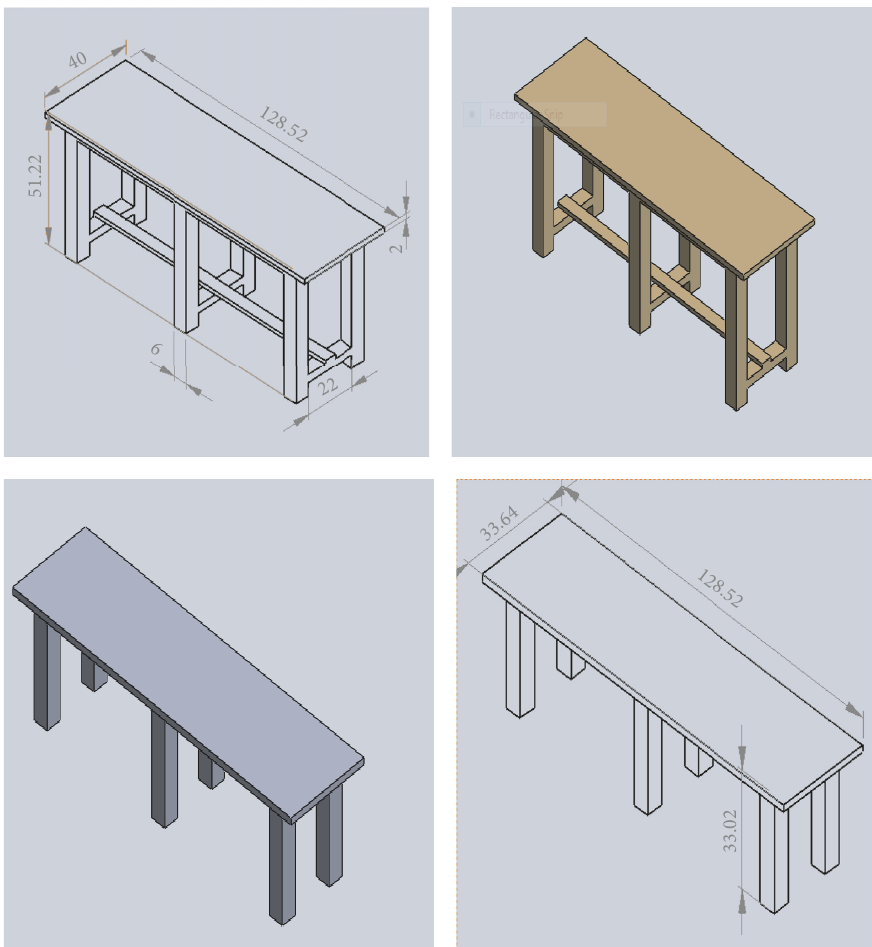
Figure 4: Representation of ergonomically designed